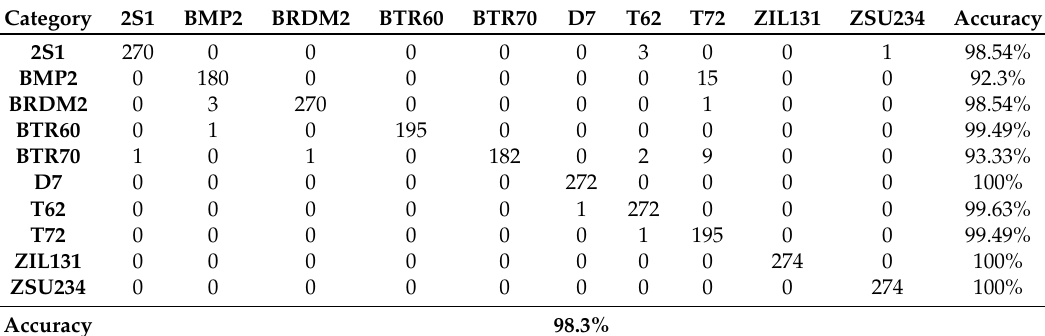
Table 4. Confusion matrix of 10-class recognition result (baseline).